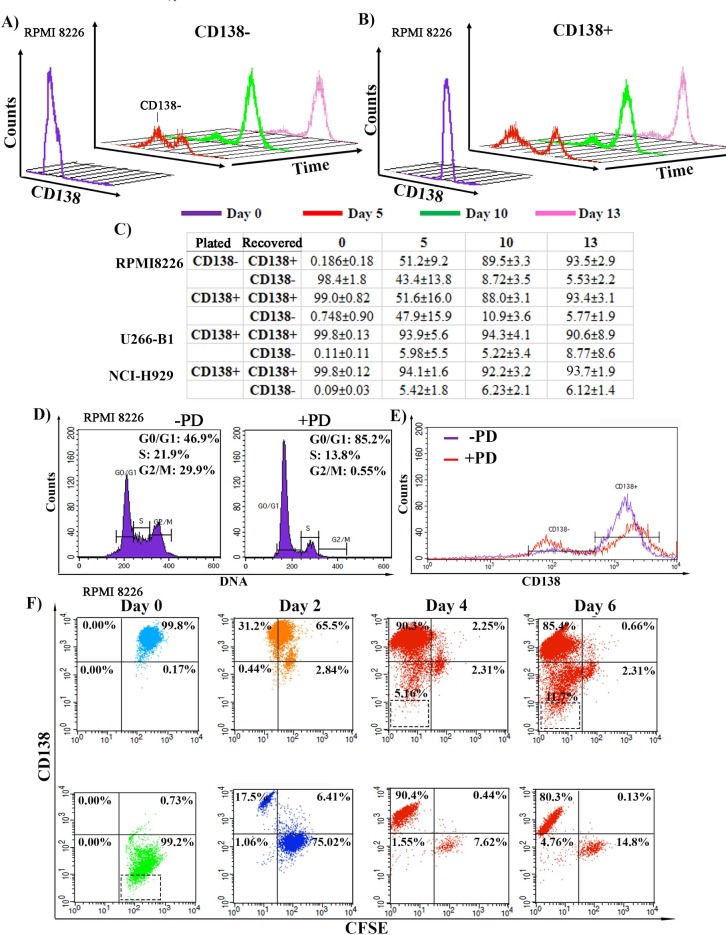
Plasticity of cells.A, B) Sorted CD138-CD38+ and CD138+CD38+ populations were plated, aliquots (10,000 cells) were analyzed for CD138 expression at days 5, 10, and 13. Purple line is CD138 content at time of plating (Representative of N = 5). Flow cytometry will not measure expansion of the cultures. C) Sorted CD138-CD38+ and CD138+CD38+ cells from U266-B1 and NCI-H929 MM lines plated and analyzed for CD138 status at days 5, 10 and 13. (N = 3, mean+/-SD) D) Cell Cycle status of RPMI8226 cells before (left) and after (right) treatment with 5μM PD0332991 (PD). E) CD138 expression of RPMI8226 cells before (purple) and after (red) PD treatment for 3 days. F) Cells were treated with 5μM PD for 3 days, stained with CFSE, washed, and then followed in culture for 6 days. Aliquots were analyzed for CFSE and CD138 over this time course. Dashed boxes are of non-viable cells (population iii) were not included in the overall percentages of each quadrant.